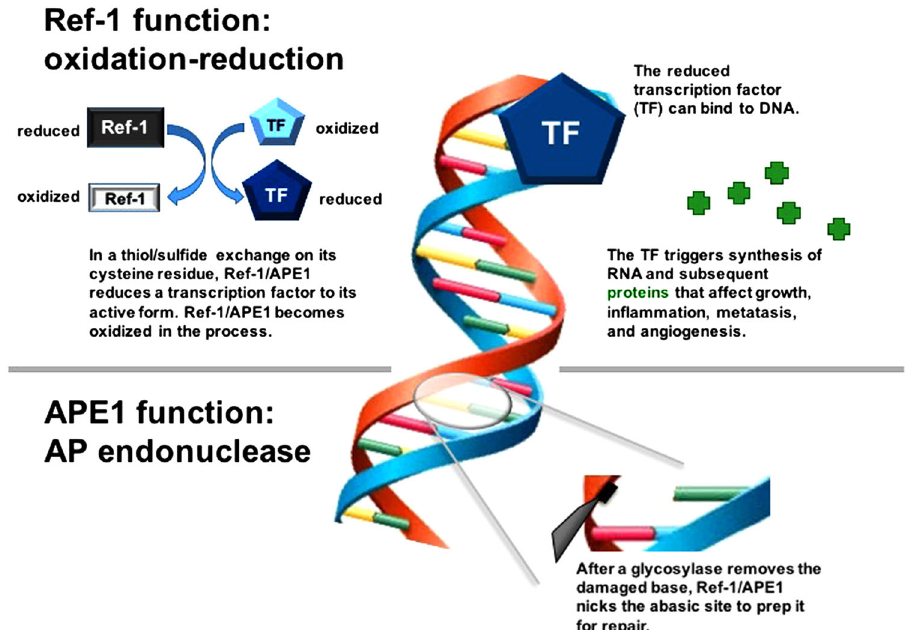
Fig. 1 Dual functions of Ref-1/APE1. Ref-1/APE1 is a multifunctional protein involved in redox signaling and DNA repair. The redox signaling function is responsible for reduction of oxidized cysteine residues in certain transcription factors (TF ’ s), leading to increased transcriptional activity and upregulation of genes involved in cell growth, in fl ammation, angiogenesis, and other cellular functions. The DNA repair function is responsible for the endonuclease activity in base excision repair, cutting the phosphodiester backbone of DNA at abasic sites created by glycosylases. These cuts allow the abasic sites to be replaced with appropriate nucleotide bases, completing the DNA base excision repair